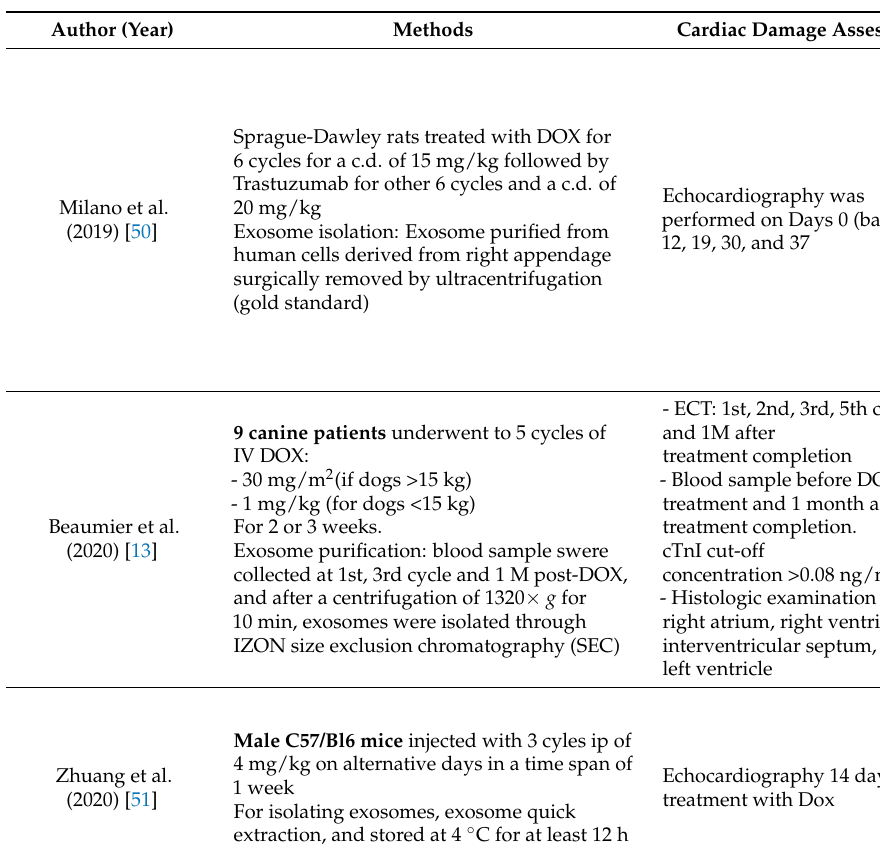
Table 3. Studies analyzing